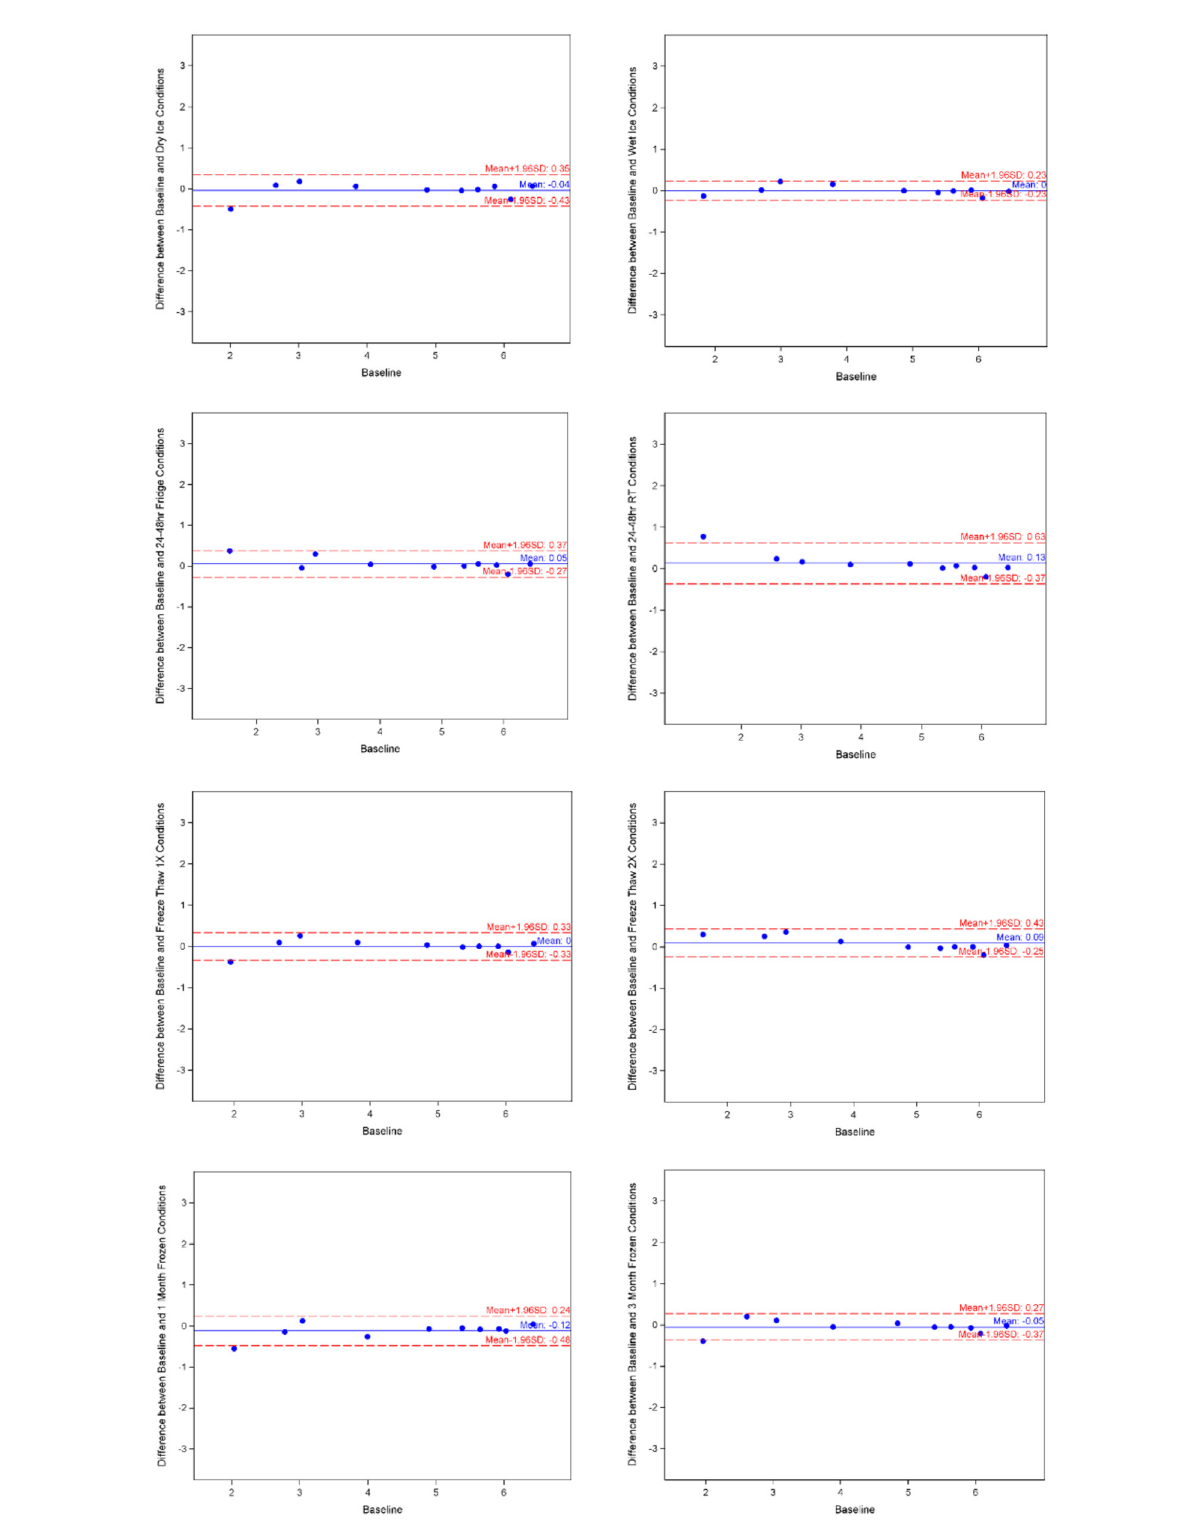
FIGURE5 MCP-1 Bland-Altman charts by experimental condition. Image made with